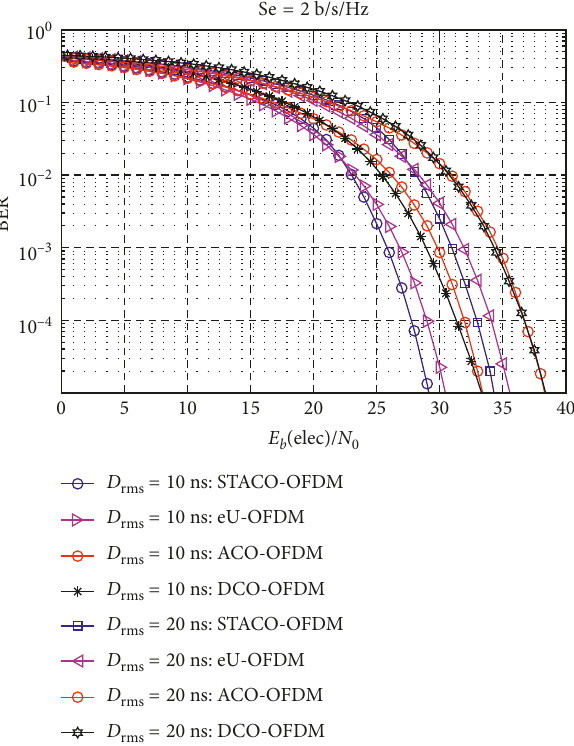
Figure 9: BER versus electrical SNR performance of STACO- OFDM, ACO-OFDM, and DCO-OFDM with spectral efficiency of 10 , 20ns. 2 bits/s/Hz over multipath channel with D rms (cid:29)